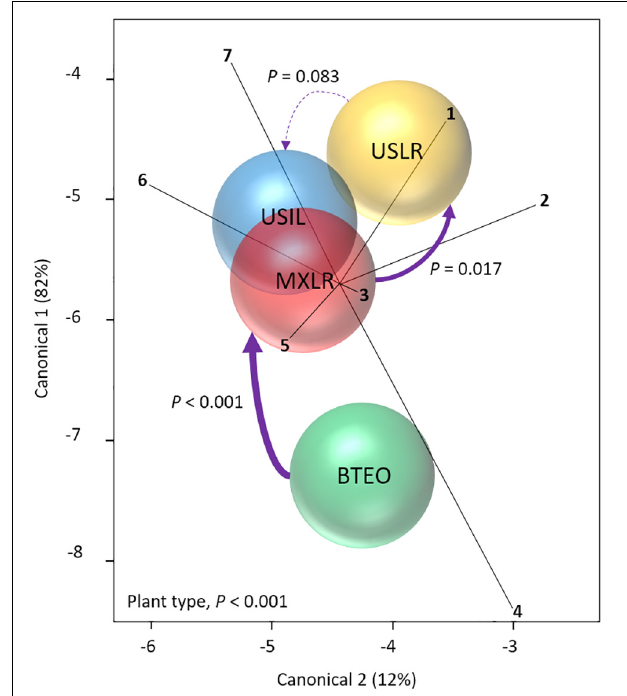
FIGURE 1 | Canonical centroid plot from a Multivariate Analysis of Variance (MANOVA) (Wilks’ λ = 0.365, P < 0.001) for plant and Western corn rootworm variables associated with plant resistance; circles represent 95% confidence intervals around multivariate means for each plant type. The model included the independent variables ‘plant type’ (Balsas teosintes, Mexican maize landraces, US maize landraces, US inbred maize lines), and ‘accessions’ nested within plant type (three accessions per plant type, not shown here), and the dependent variables larval weight (ray 1), foliar weight (2), leaf surface area (3), plant growth (4), larval survivorship (5), root weight (6), and lost plant growth (7). Significant pair-wise comparisons between plant types ( a priori contrasts with critical P of 0.017, per Sidak correction) are indicated by solid arrows (width is proportional to the confidence level); dashed arrow indicates a non-significant difference. The pair-wise comparisons are between plant types representing the domestication (BTEO vs. MXLR), spread (MXLR vs. USLR), and breeding (USLR vs. USIL) transitions evident in maize. BTEO, Balsas teosintes; MXLR, Mexican landraces; USLR, US landraces; USIL, US inbred